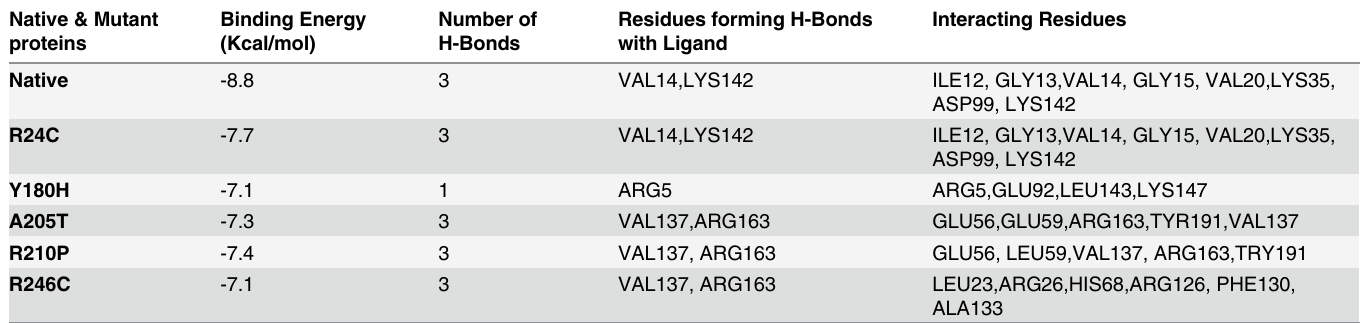
Table 2. Binding energies of CDK4 native and mutant proteins with drug flavopiridol. Native & Mutant proteins